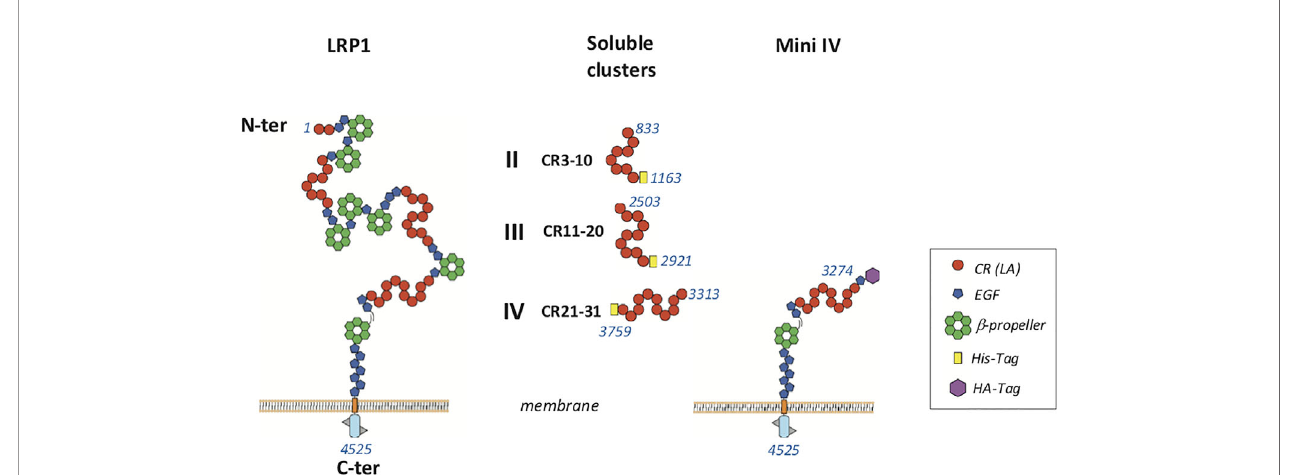
FIGURE 1 | Schematic representation of LRP1 fragments used in this study LRP1 clusters II, III and IV were produced in 293-F mammalian cells with a His-Tag at the C-terminal extremity. Membrane full-length LRP1 and minireceptor IV (mini IV) were used for cellular interaction studies. CR, complement repeat; LA, LDL receptor class A; HA, hemaglutinin; EGF, epidermal growth factor. Amino acid numbering of mature LRP1 is indicated in